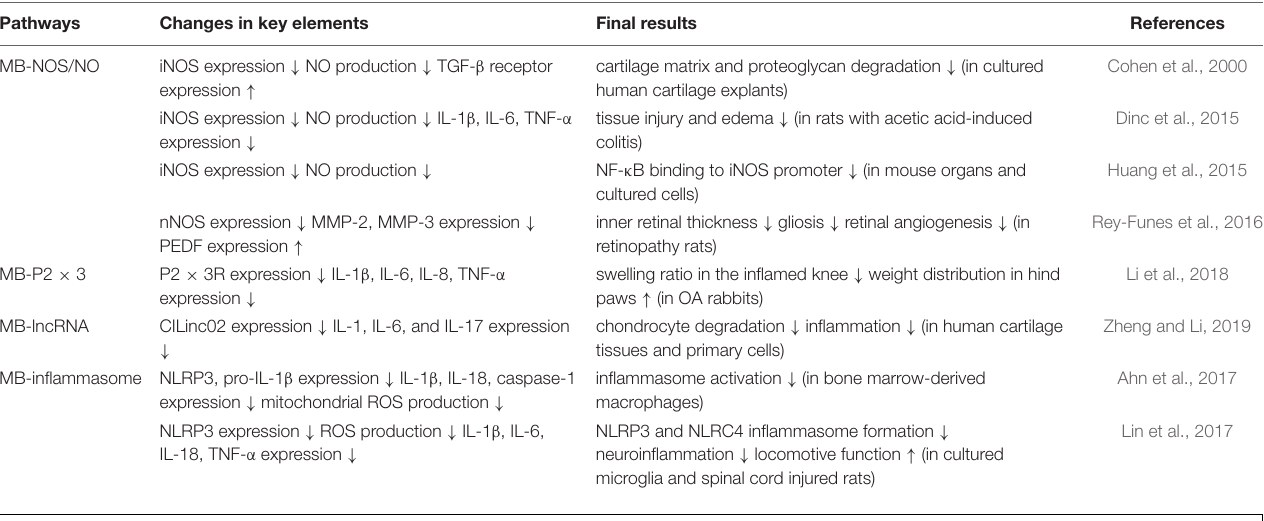
TABLE 1 | MB-mediated multiple anti-inflammation pathways.